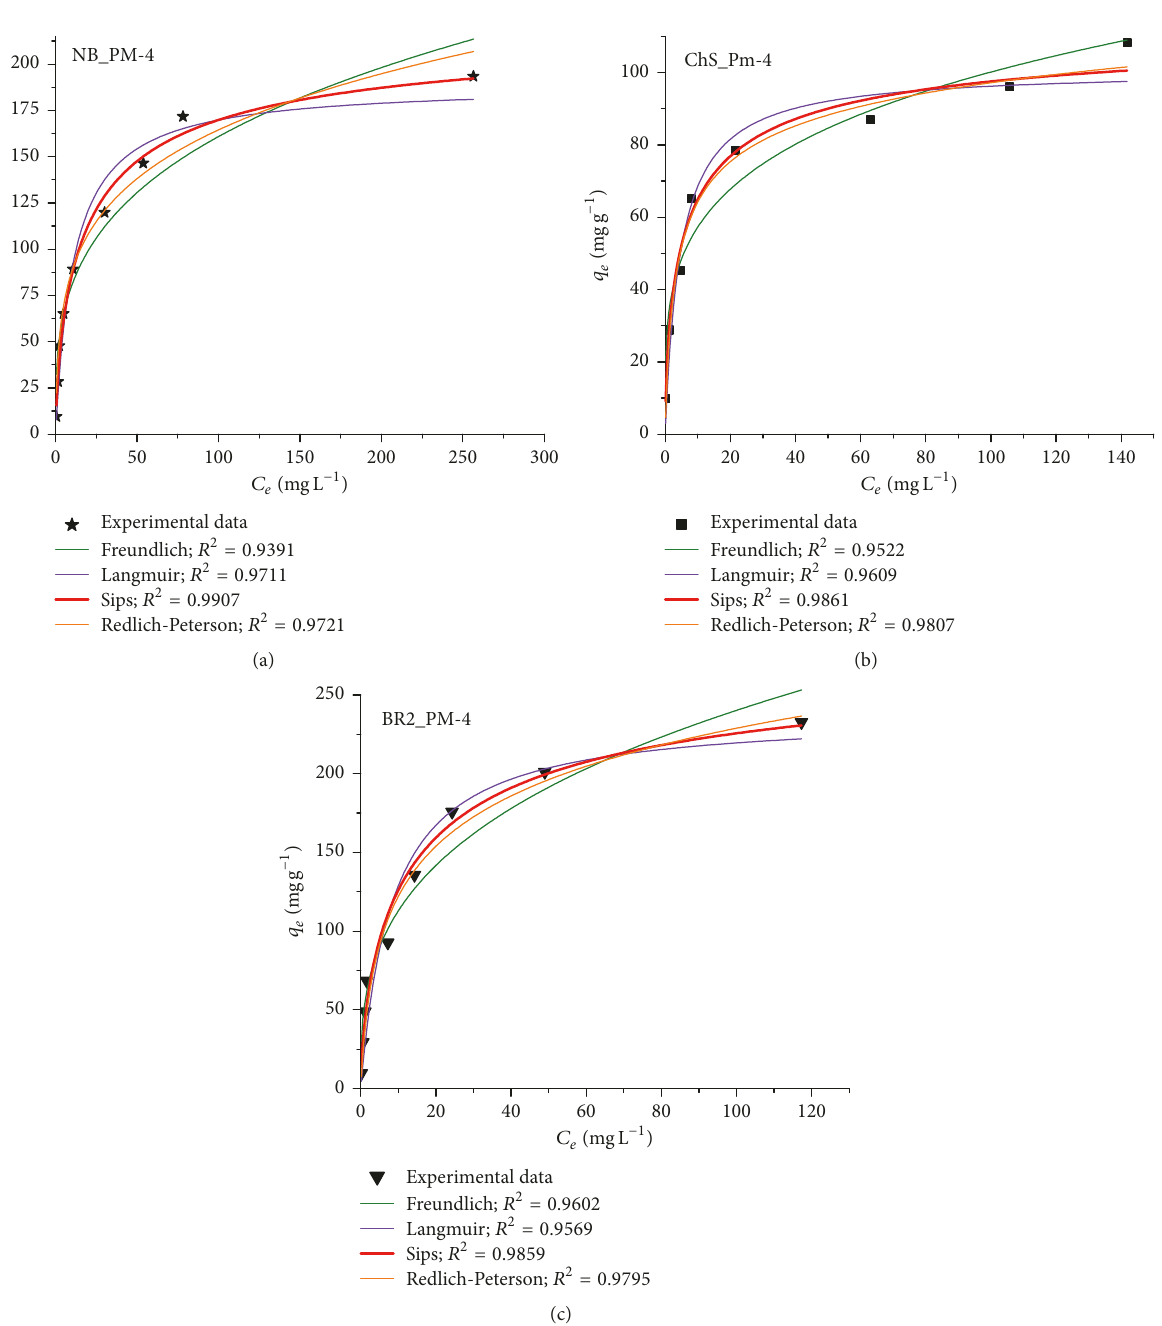
The best isotherm model that fits with the experimental data was the Sips isotherm model (Figure